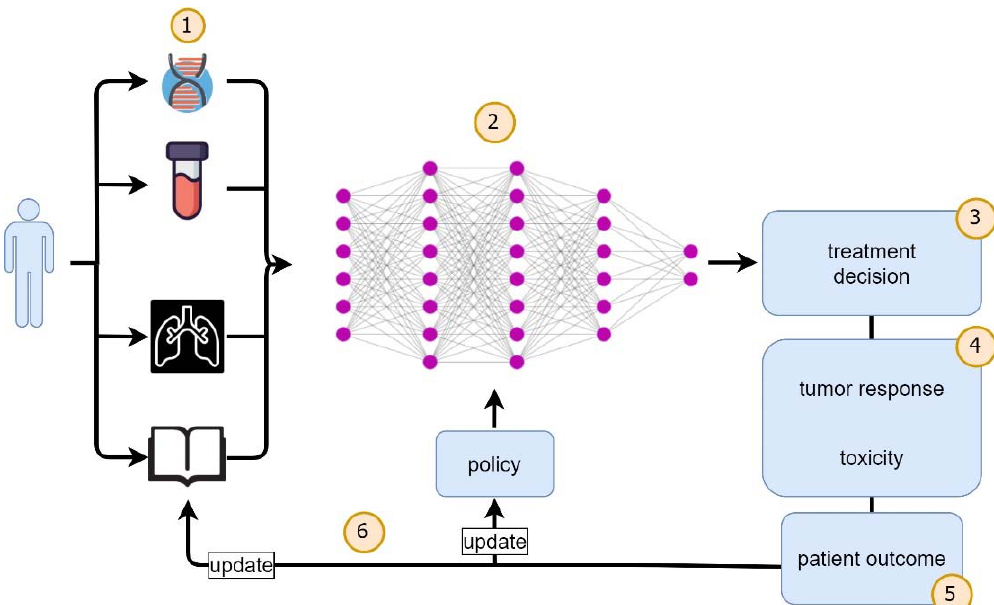
Figure 3. Iterative workflow of a reinforcement learning approach to precision oncology. For the individual patient, multimodal data (1), e.g., from genetic assays, laboratory tests, radiographic images and electronic health records, serve as an input for a reinforcement learning (RL) framework (2)—here, depicted as a deep neural net—which selects an action such as a treatment decision (3) according to its policy. This treatment decision will affect tumor response and toxicity (4) simultaneously and thus, ultimately, affect long-term patient outcome (5). This is translated into a reward signal for the RL agent which results in a policy update (6). At the same time, the state of the patient changes. For example, tumor response could be measured with radiographic imaging, and/or toxicity could be monitored by laboratory values and documentation in the electronic health record. This update of the state initiates a new cycle where updated inputs to the RL framework lead to a new treatment decision according to the updated policy, and the loop is closed. Table 3. Recent studies of reinforcement learning (RL) for adaptive dosing of antineoplastic drugs in cancer. Reference